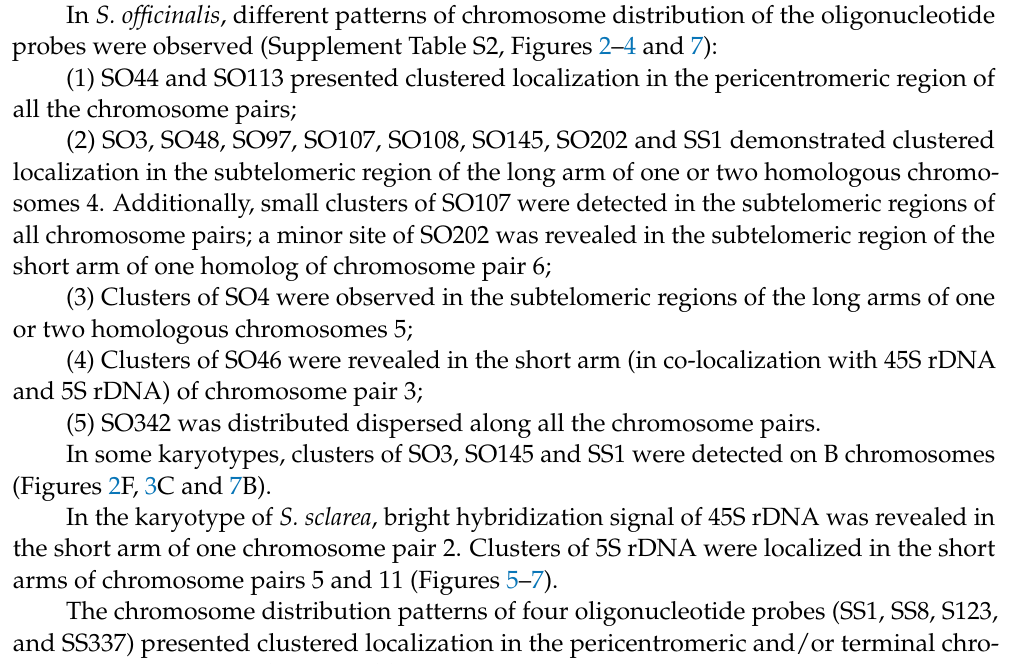
Figure 2. Localization of 45S rDNA, 5S rDNA, and oligonucleotide-based probes SO97 ( A ), SO107 ( B ), SO342 ( C ), SO113 ( D ), SO44 ( E ), and also SO145 and SS1 ( F ) on chromosomes of Salvia officinalis . Merged fluorescent images after multicolor FISH with different combinations of the probes. Probe colors are shown on the left. Chromosome DAPI-staining—blue. Asterisks indicate clusters of SS1 colocalized with SO145. Arrows point to B chromosomes. Scale bar—5 μ m.